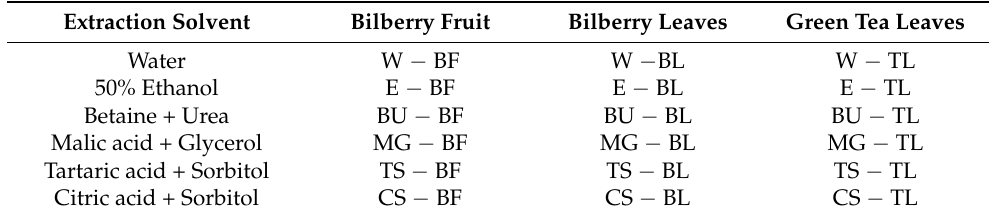
Table 2. Abbreviations of the investigated